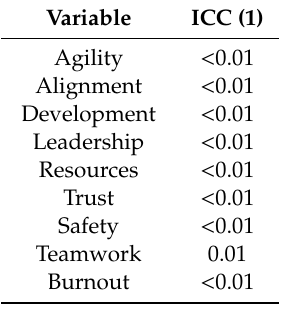
Table 6. ICC (1) values for employee job attitudes and